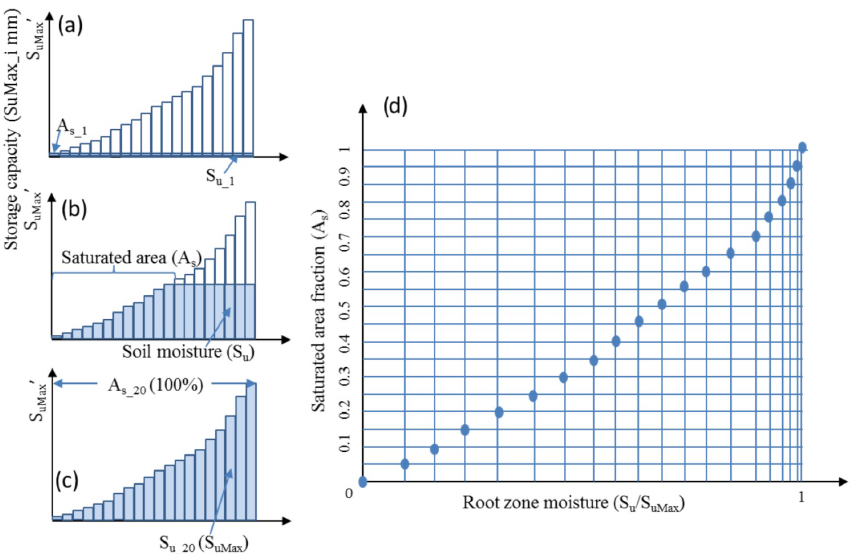
Figure 3. The conceptual model of the HSC model. Panels (a) , (b) , and (c) illustrate the relationship between soil moisture ( S u ) and saturated area ( A s ) in different soil moisture conditions. In (d) , 20 different S u – A s conditions are plotted, which allow us to estimate A s from S u .